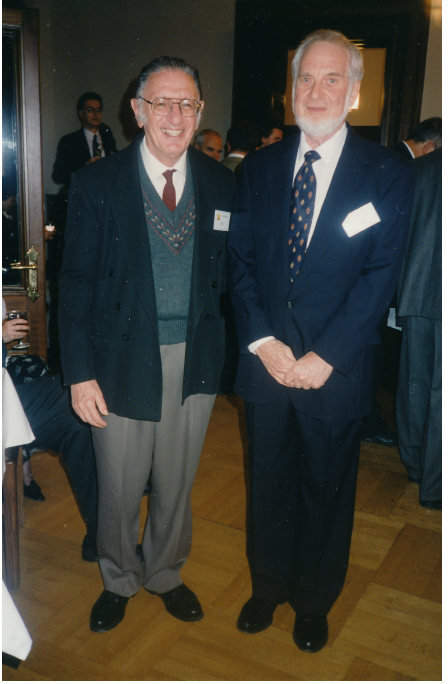
Figure 2: Abe Sklar (left) and Bert Schweizer (right) at the 35th International Symposium on Functional Equations held Septem- ber 7–14, 1997 in Graz, Austria (participation in this meeting was by invitation